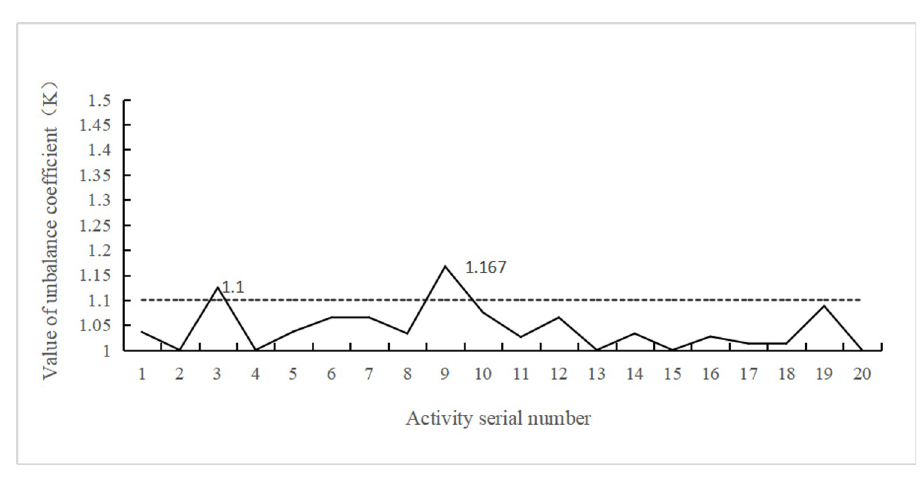
Fig 7. Value of K i .